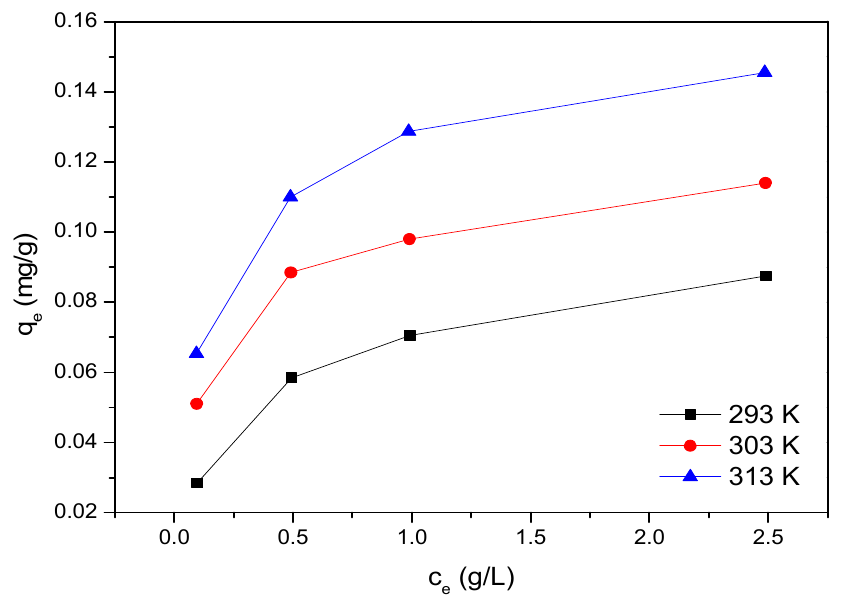
Figure 6. Adsorption isotherms of PCE-1 on LBSP at three different temperatures. (293 K, 303 K, and 313 K) as indicated in the legend.